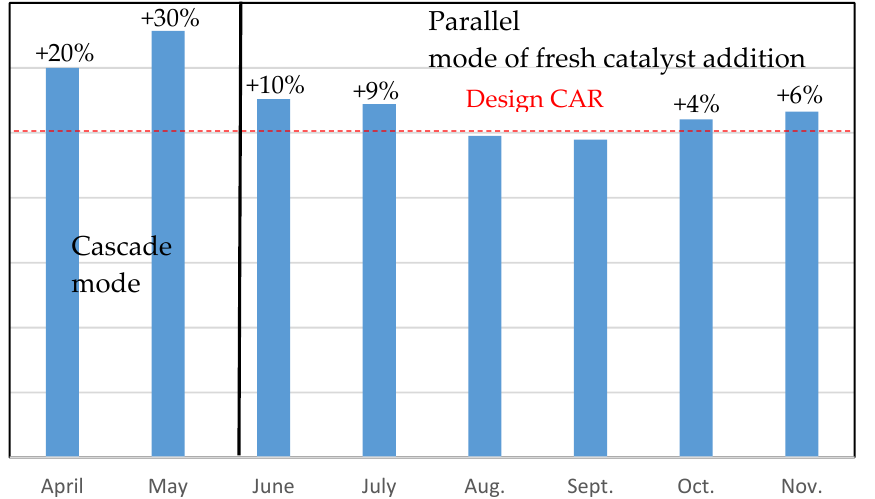
Figure 10. Variation of catalyst addition rate during cascade and parallel modes of fresh catalyst addition for the investigated period of time.